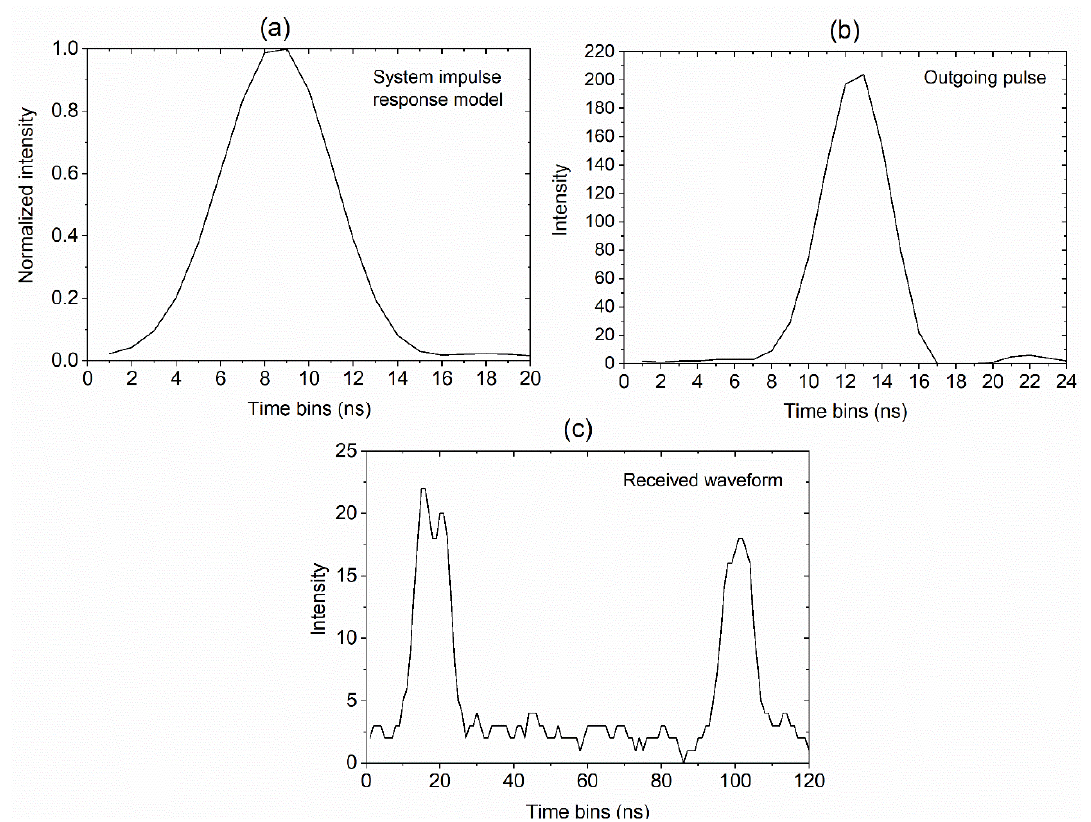
Figure 4. A subset of ( a ) the system impulse response model, ( b ) an outgoing pulse, and ( c ) the corresponding received waveform recorded by the Riegl LMS-Q680i system.